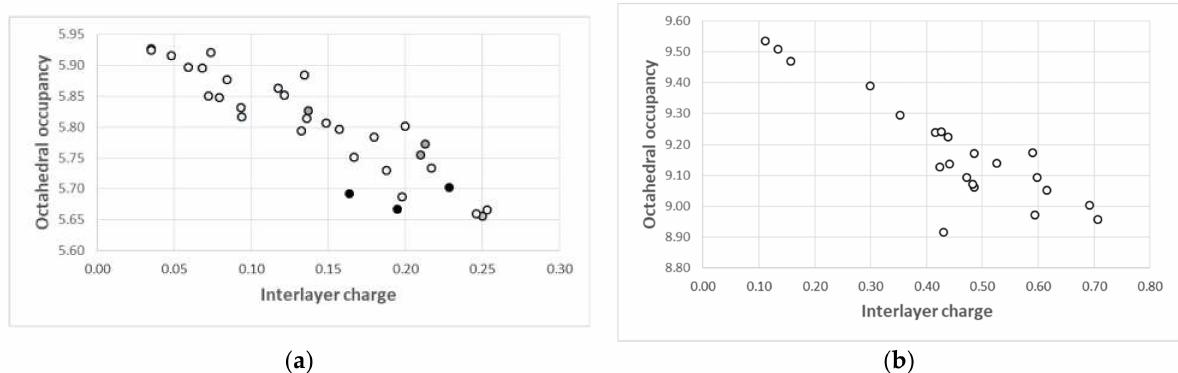
Figure 13. ( a ) Octahedral occupancies as a function of the interlayer charge for chlorite. Structural formulas are calculated per half formula unit (14 O). ( b ) Octahedral occupancies as a function of the interlayer charge for corrensite. Structural formulas are calculated per half formula unit (25 O). Black dot: compartment 1, white dot: compartment 2, grey dot: compartment